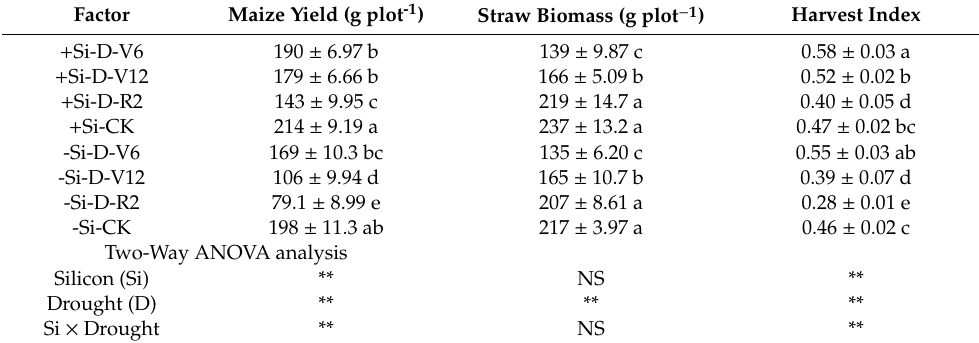
Table 2. The e ff ect of silicon fertilization and drought stress on maize yield, straw biomass, and the harvest index.